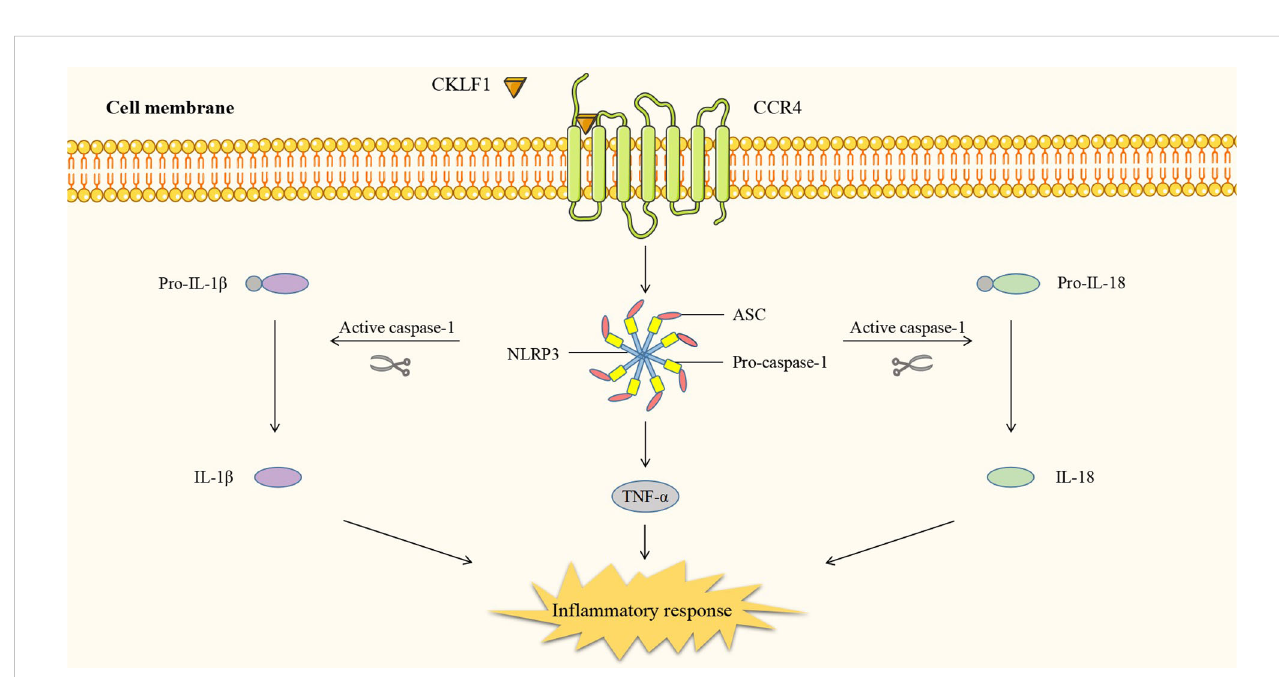
FIGURE 6 CKLF1 binds to CCR4 and mediates the activation of downstream NLRP3 in fl ammasomes. Activated caspase-1 induces maturation and release of pro- in fl ammatory cytokines and exacerbates in fl ammatory